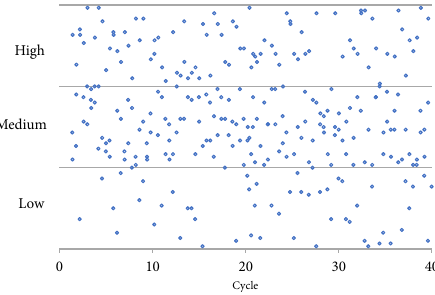
Figure 5. Evolution of the innovative spirit of the new generation entrepreneurs in the spontaneous innovation scenario